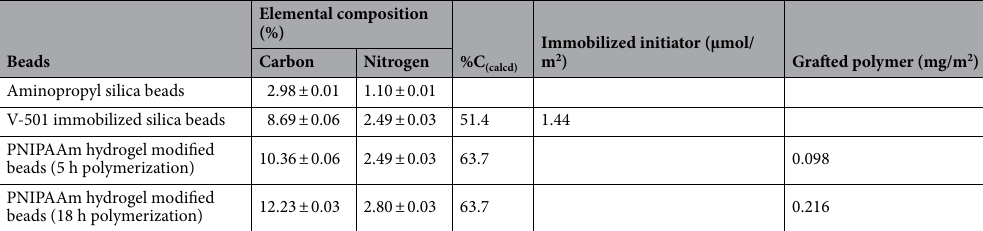
Table 1. Characterization of thermo-responsive hydrogel-modified beads using CHN elemental analysis. %C (calcd) was calculated as the percentage of the molecular weight of carbon in the initiator and polymer. The amount of initiator and polymer on silica beads were estimated using the carbon composition.